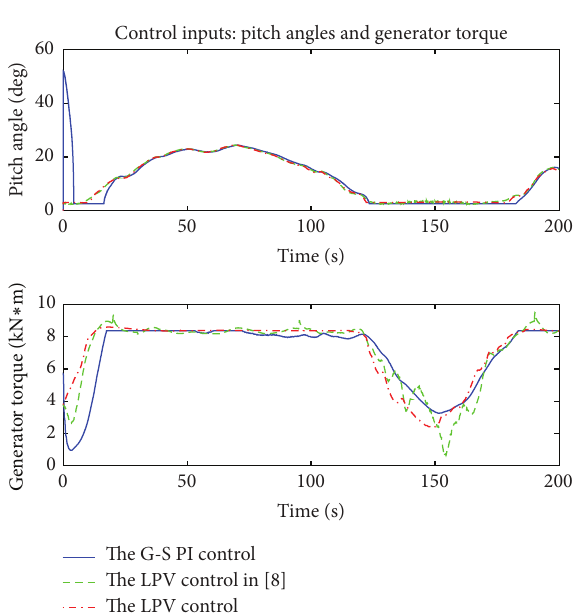
condition in the full load region, but in LPV2 it is perfectly denied.